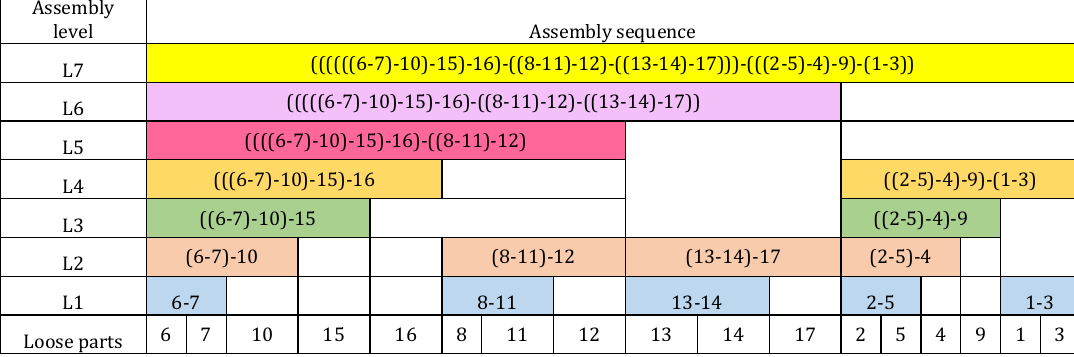
Table 3. Assembly level calculation for valid sequence